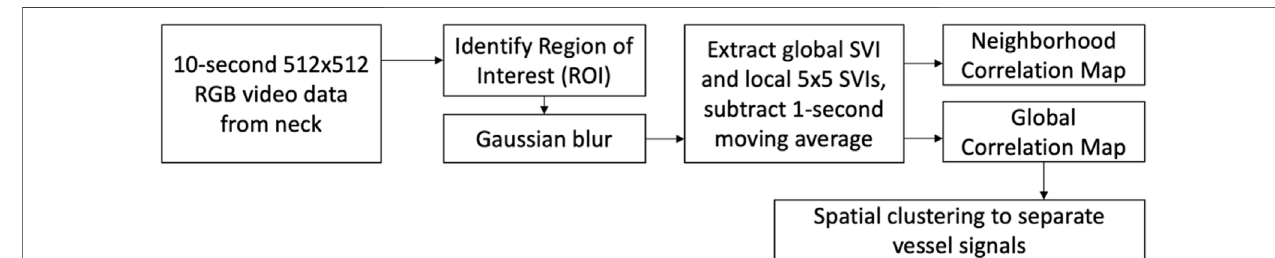
FIGURE 2 | Acquisition setup.